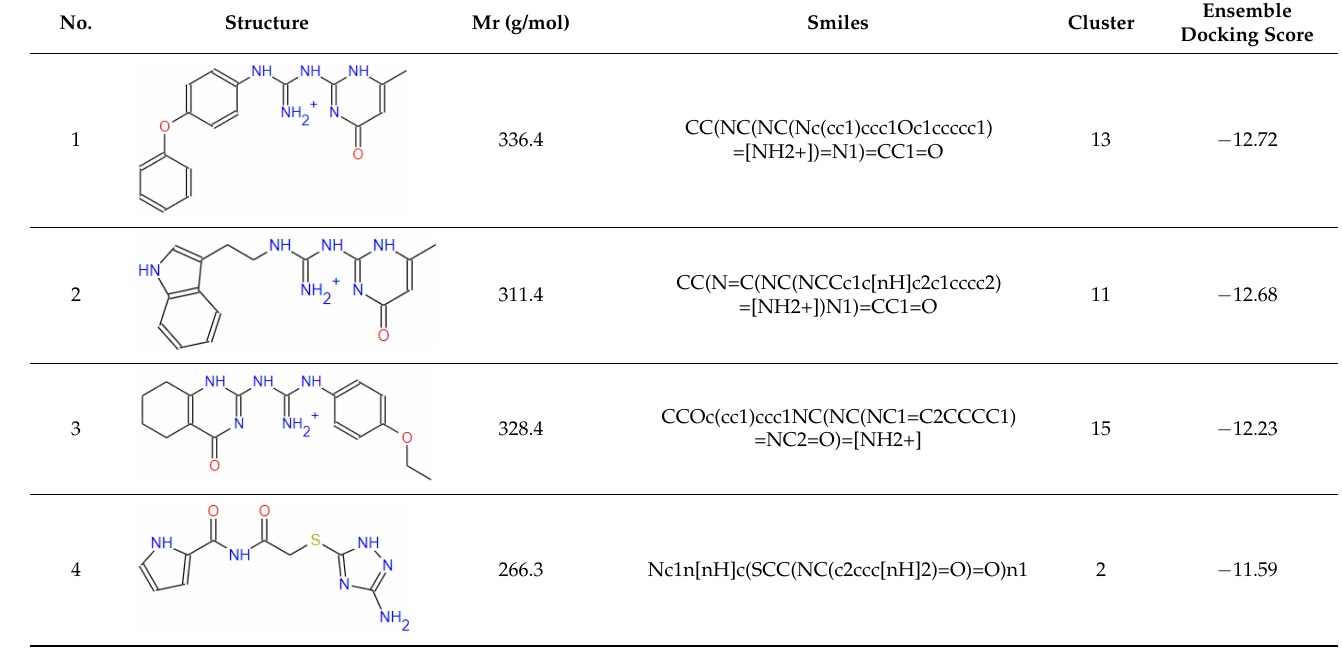
Table 1. The top five hits from the high-throughput virtual screening (HTVS) on the SARS-CoV-2 RdRp together with three nucleoside mimic RdRp inhibitors for comparison. The extended list is provided in Supplementary Materials. No.